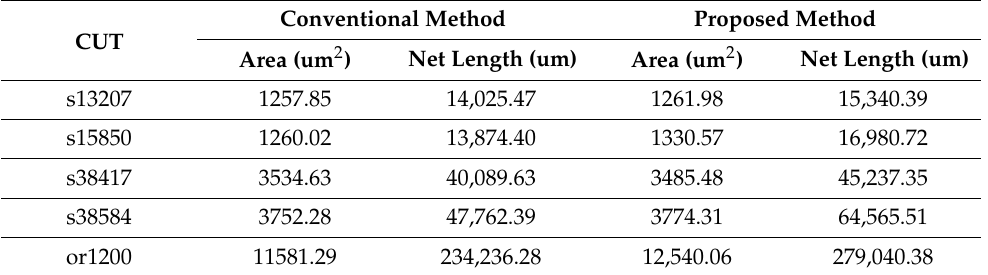
Table 7. Comparison of the routing